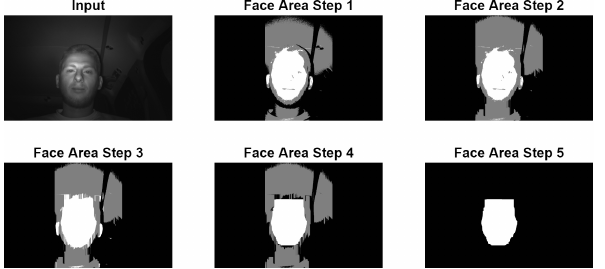
Figure 3. Example of input image converted from grayscale to